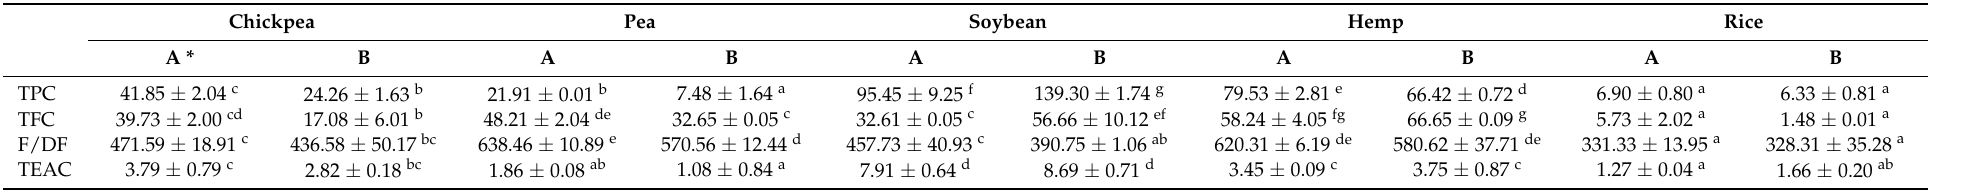
Table 3. The phenolic composition and antioxidant capacity (per 100 g of fresh weight) of different flours. Data presented as means ± standard deviation from triplicate